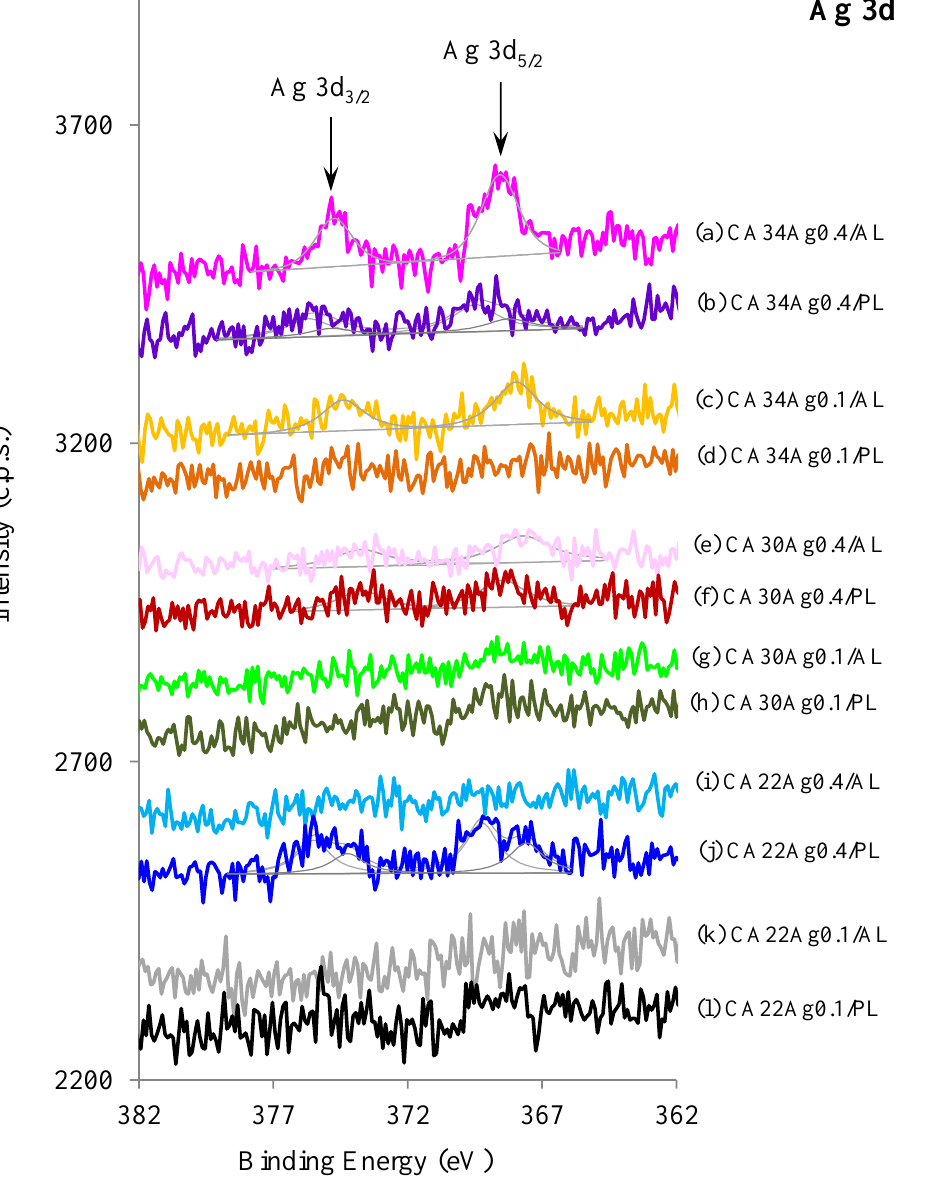
Figure 8. XPS Ag 3d regions of active layers (AL) and porous layers (PL) of CA/Ag with 0.1% wt Ag and 0.4% wt Ag membranes.